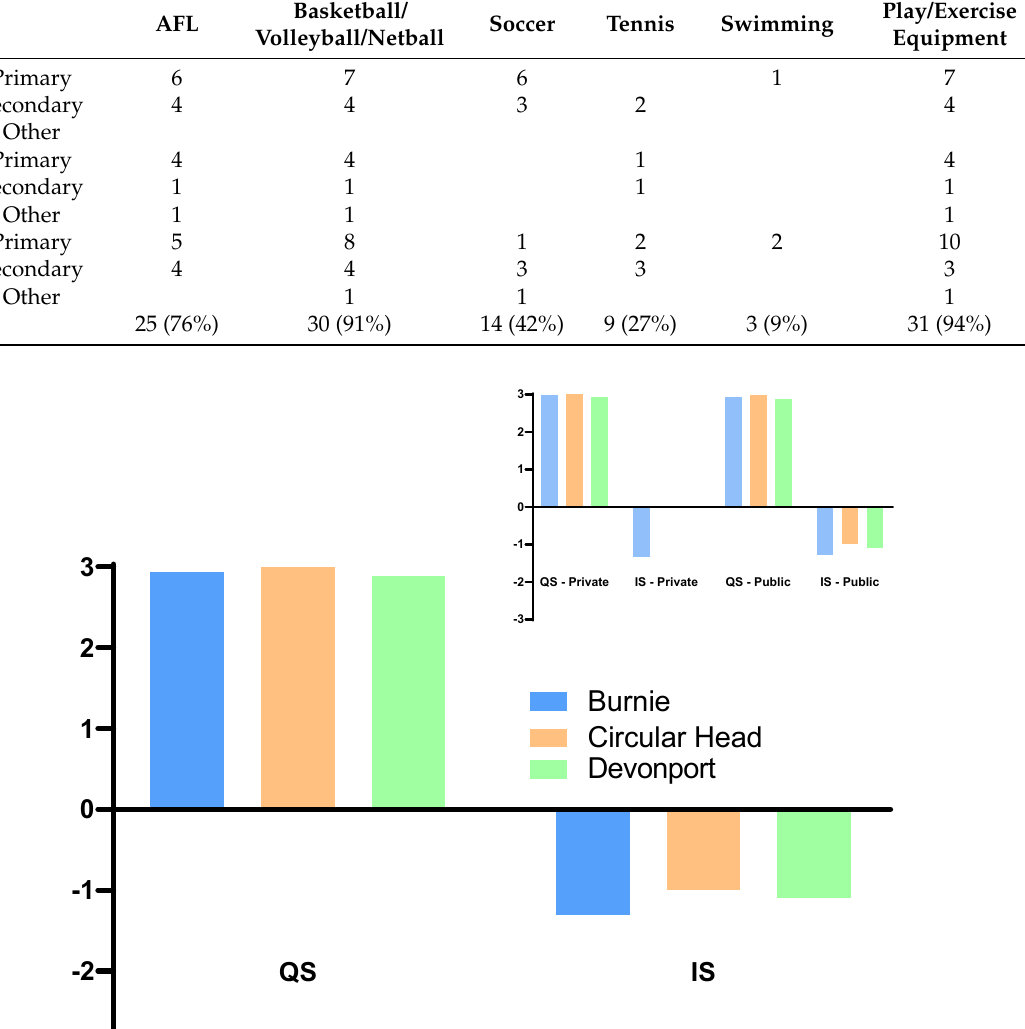
Table 2. Available facilities stratified by school type and location.